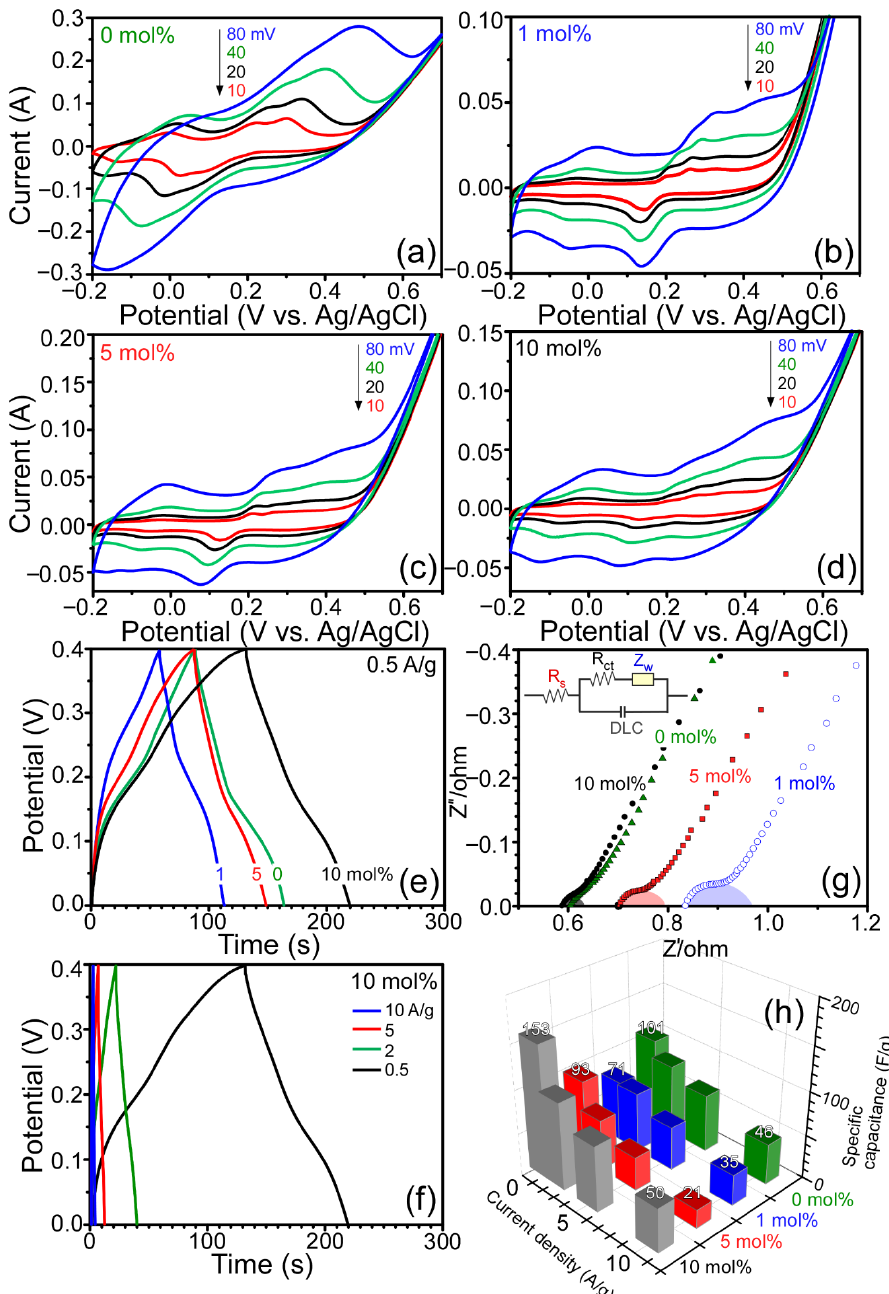
Figure 5. Cyclic voltammograms at various scan rates for ( a ) 0 mol%; ( b ) 1 mol%; ( c ) 5 mol%; ( d ) 10 mol% samples, ( e ) galvanostatic charge–discharge (CD) curves at 0.5 A/g for the four samples, ( f ) CD curves for the 10 mol% sample with different current densities, ( g ) Nyquist plots with the plausible equivalent circuit model, ( h ) the measured specific capacitances.